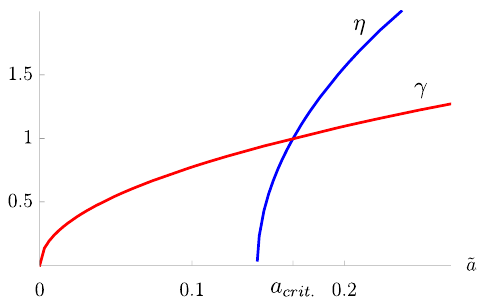
Figure 11 . The exponents of the short-distance asymptotics of the (cid:12)elds (cid:26) and (cid:18) with no higher- dimensional derivative terms included. Here we take (cid:24) 1 = 1, (cid:24) 2 = 1 : 1. The critical value of the source of the radial (cid:12)eld, a crit : , is indicated according to eq.